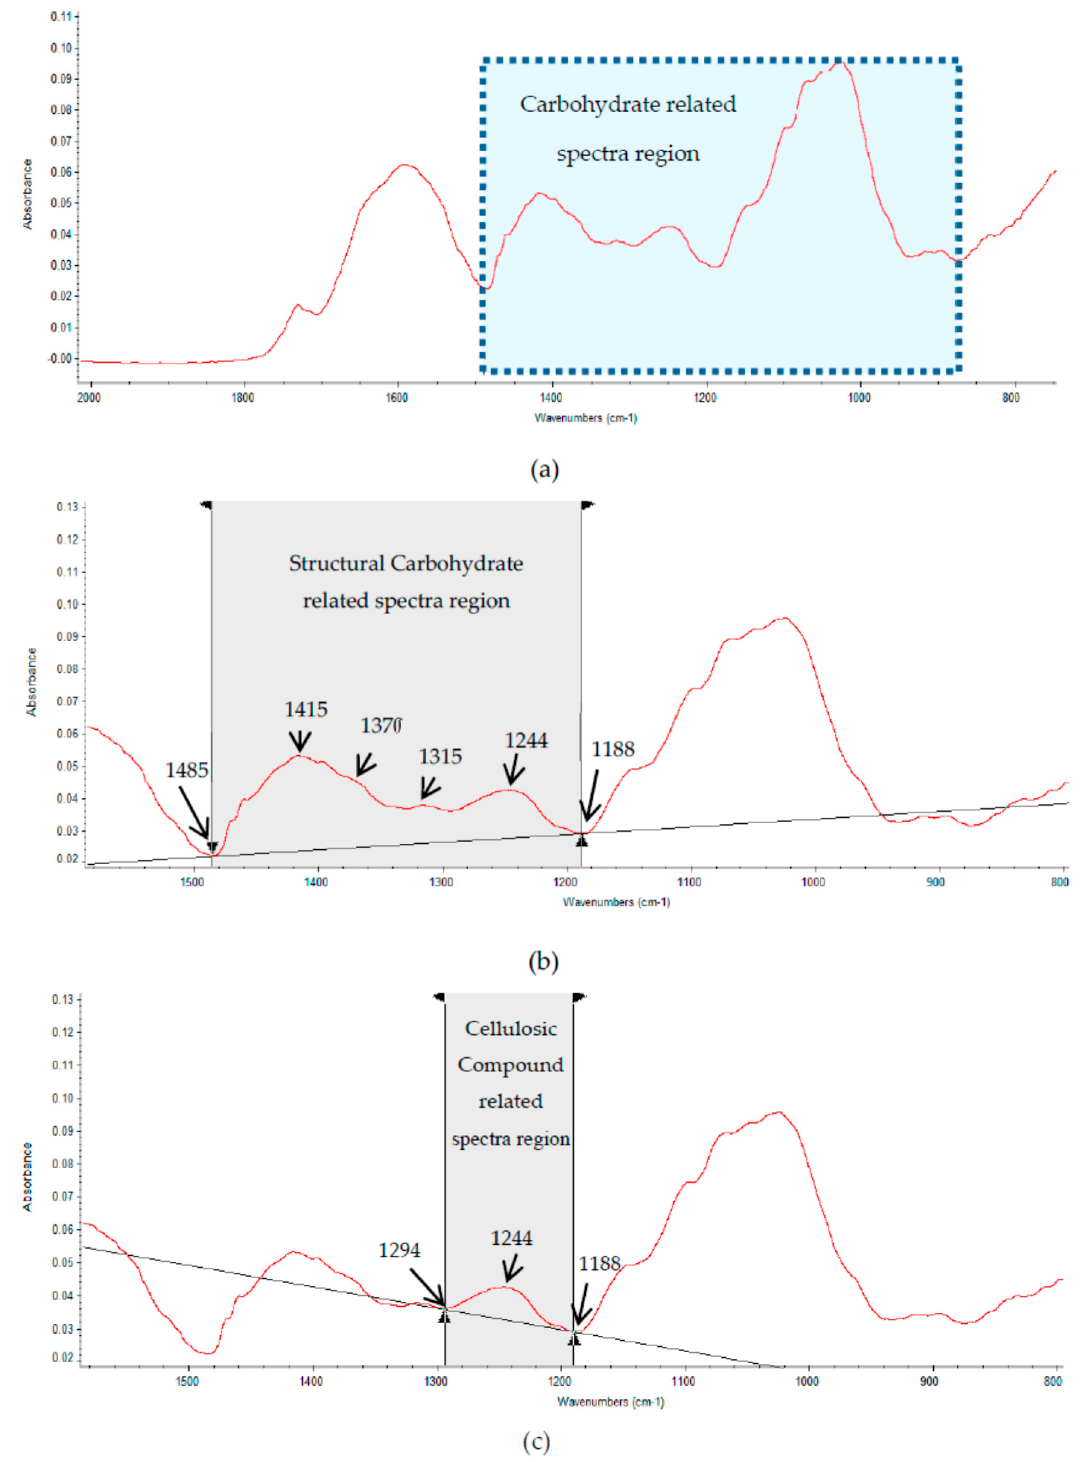
Figure 2. Cont. Figure 2.